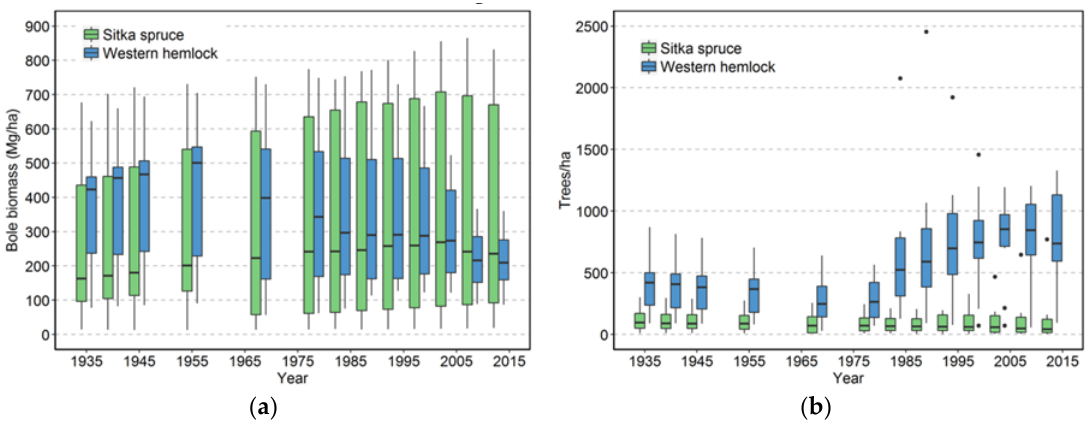
Figure 11. Biomass ( a ) and trees per ha ( b ) for the two major tree species over time.